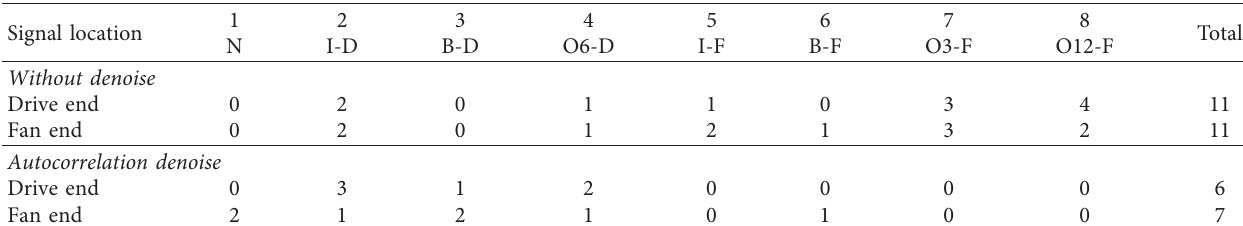
Figure 7: Box plot of the R´enyi entropy distribution of (a) drive end and (b) fan end. Table 3: Box plot outlier quantity of the R´enyi